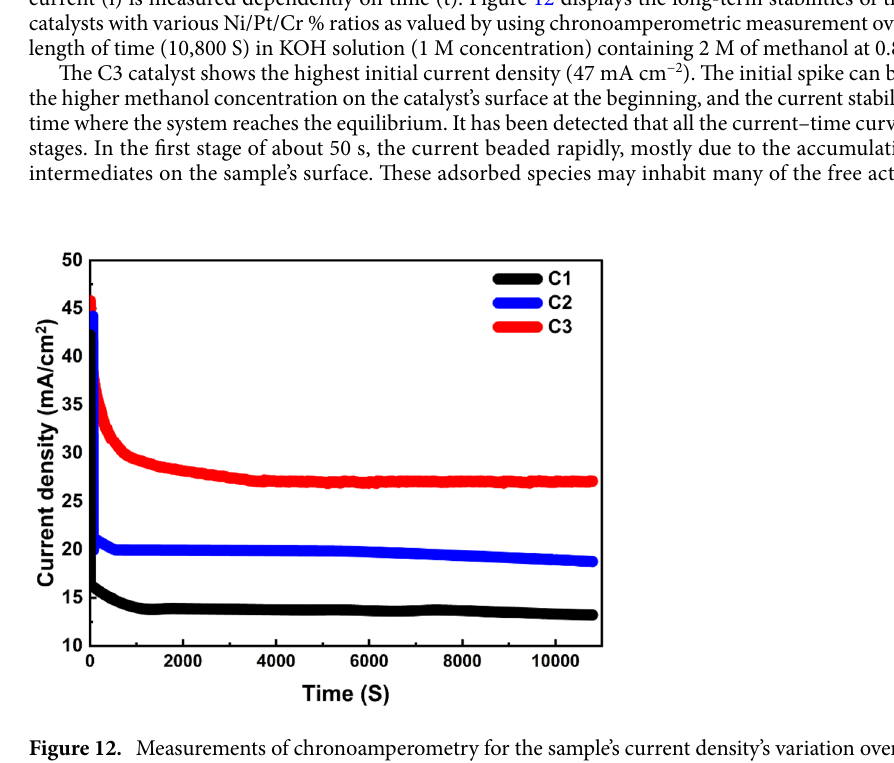
Figure 12. Measurements of chronoamperometry for the sample’s current density’s variation over time for C1, C2, and C3 in